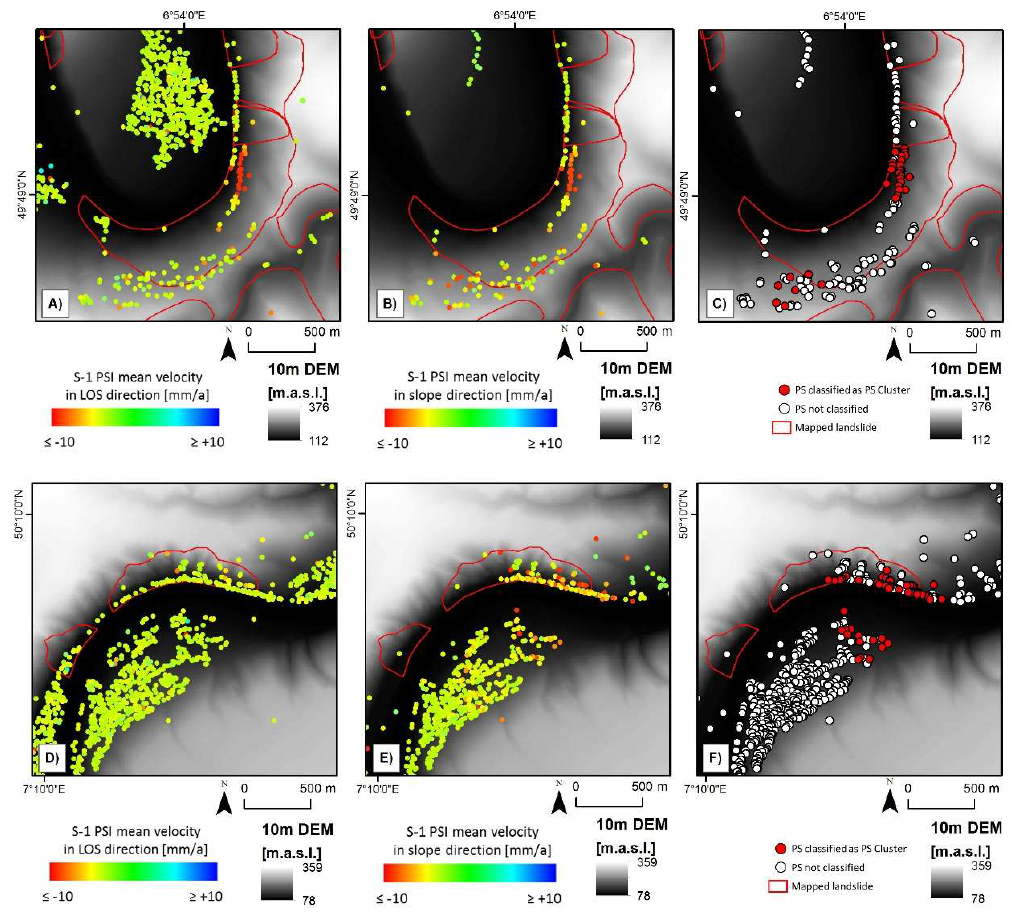
Figure 4. ( A , D ) visualize the Sentinel-1 PSI mean velocity in the LOS direction. ( B , E ) show the results of the conversion in a slope direction. PSs indicating uphill motion and PSs in flat areas are discarded. ( C , F ) show the results of the PS cluster analysis. The location of ( A – C ) is indicated in Figure 3A, number 1. The location of ( D – F ) is indicated in Figure 3A, number 2. A DEM © GeoBasis-DE/BKG 2018 [19] serves as background.